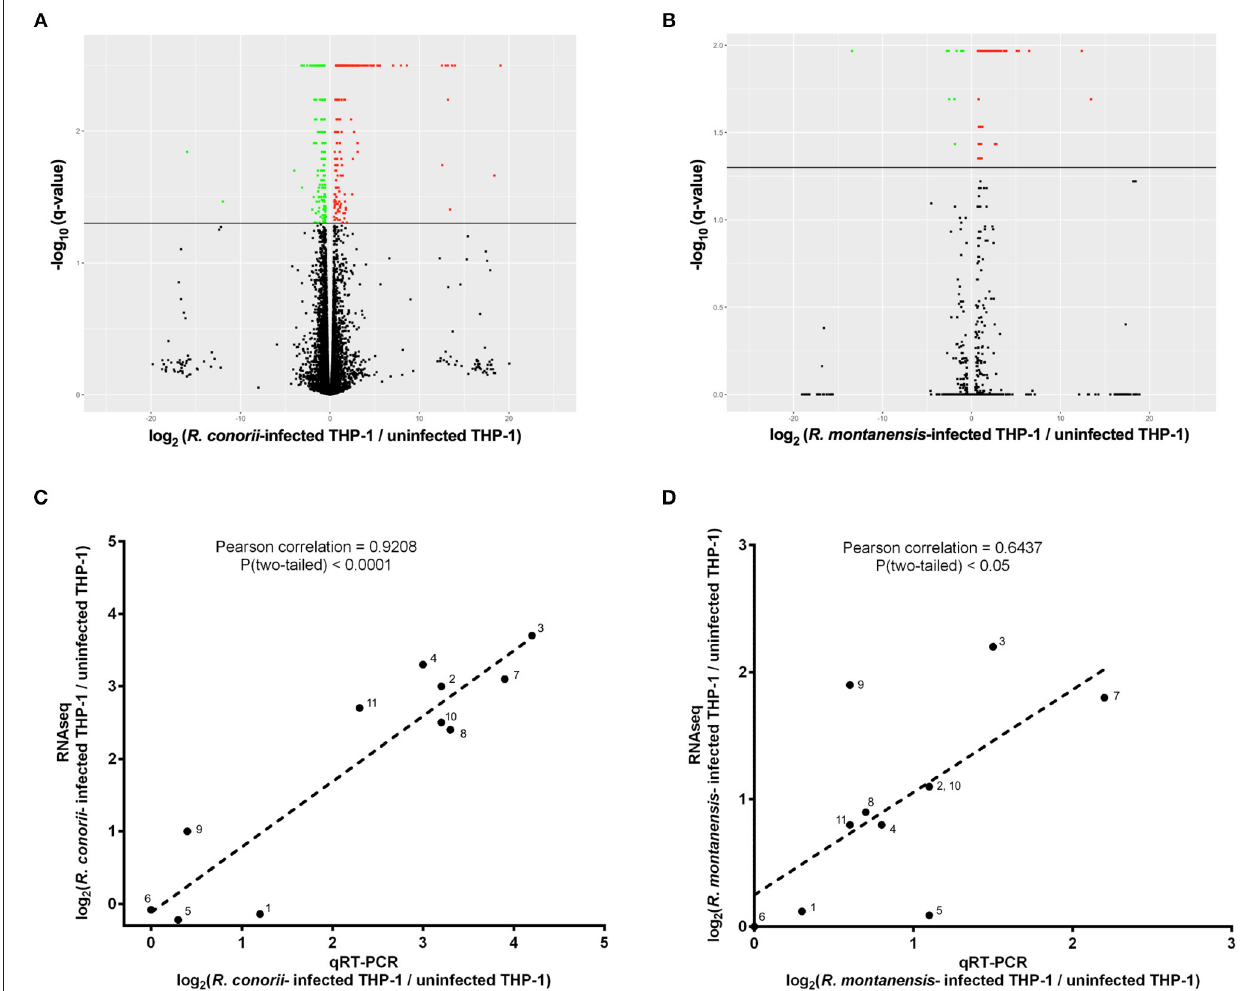
FIGURE 1 | SFG Rickettsia trigger reprogramming in THP-1 macrophages early in infection. (A,B) Volcano plots of log 2 fold change ratio of the expression levels in R. conorii - (A) and R. montanensis - (B) infected THP-1 macrophages over that in uninfected cells plotted against the -log 10 ( q -value). Statistically differentially expressed genes found in increased abundance and in decreased abundance are represented in red and green, respectively (FDR < 0.05). See also Tables S1 , S2 . (C,D) Validation of RNA-seq data by comparing the transcriptional fold changes of 11 randomly selected genes determined by RNA-seq and an independent method (q-RT-PCR) for R. conorii - (C) and R. montanensis - (D) infected cells. Pearson analysis of correlation and respective significant test (two-tailed) were performed in GraphPad Prism. R. conorii -infected: r = 0.9208, N = 11, p < 0.0001 and R. montanensis -infected: r = 0.6437, N = 11, p < 0.05. Gene labeling: 1-B2M; 2-BTG2; 3-CD69; 4-EGR1; 5-EMC7; 6-G6PD; 7-IER3; 8-KLF10; 9-MTRNR2L6; 10-OTUD1; 11-PP1R15A. See also Table S3